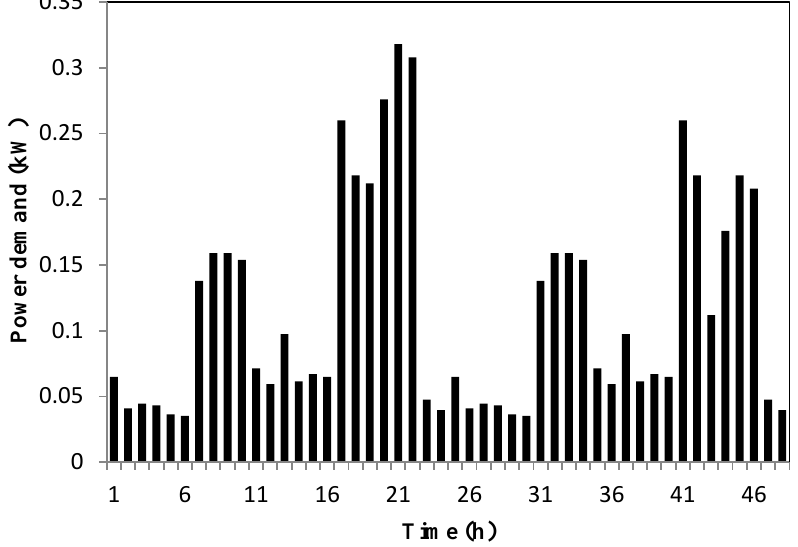
Figure 7. Predicted load profile of a house during off-peak hours over a 48 h period.